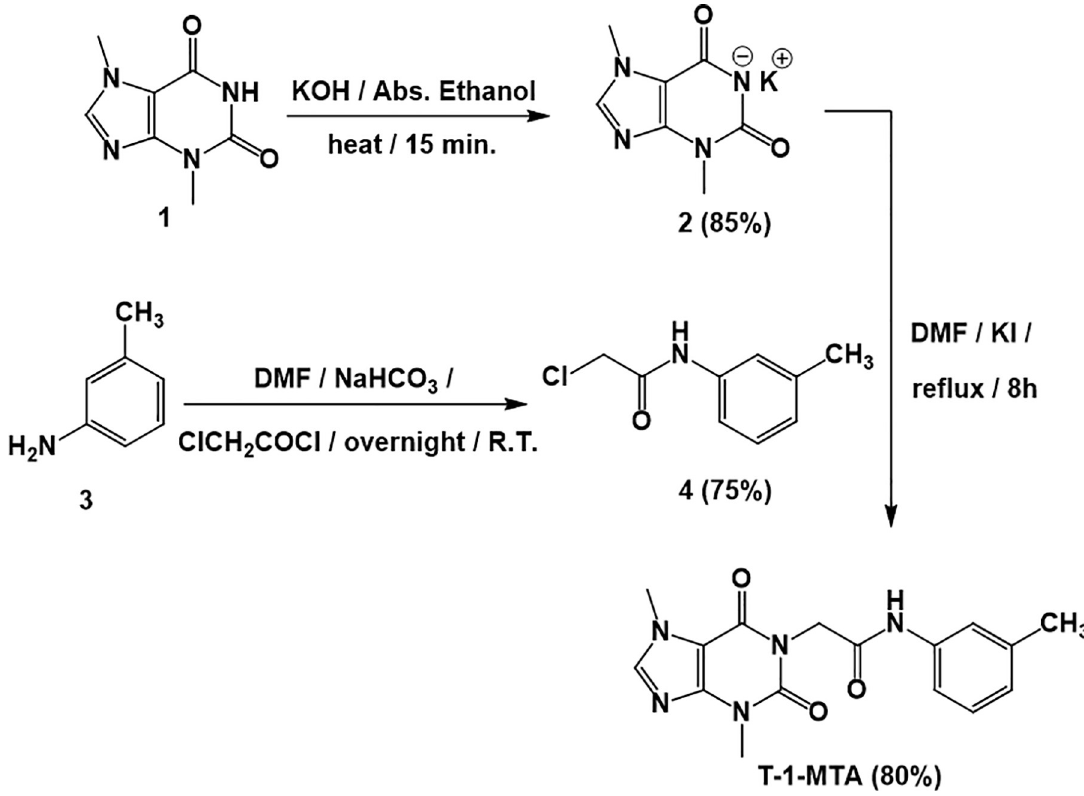
Scheme 1. Synthetic pathway of T-1-MTA.